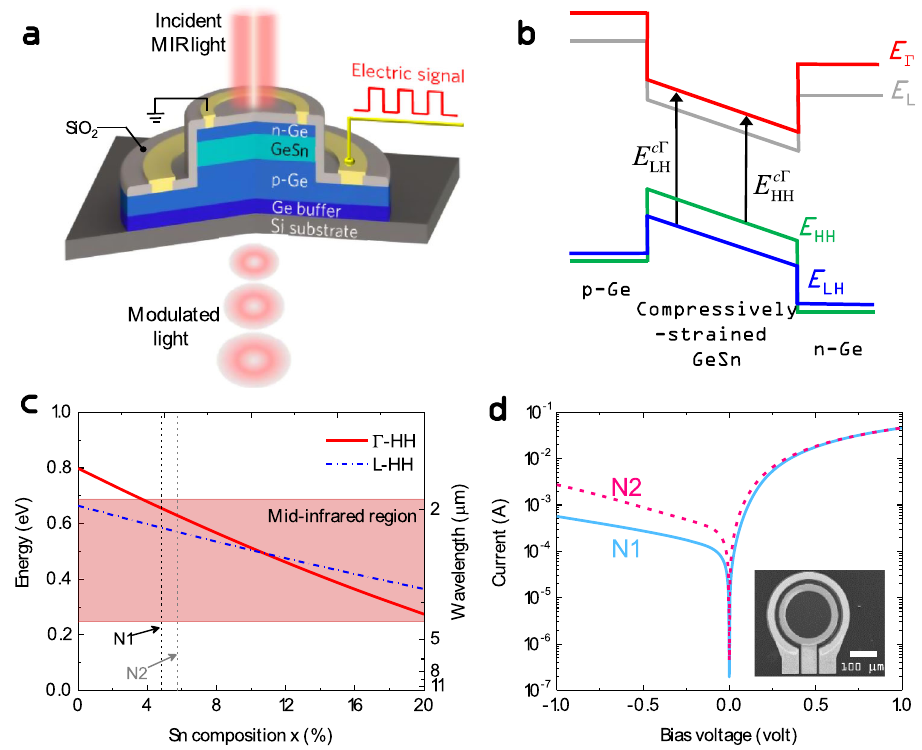
Fig. 2 GeSn p-i-n diodes on silicon for mid-infrared electro-absorption modulation. a Schematic of our designed normal-incident GeSn p-i-n diode on (001) silicon for optical modulation (not to scale). The mid-infrared (MIR) light beam is incident on the top of the device and transmitted through the GeSn active layer. AC bias voltage is applied to the p-i-n diode to modulate the MIR light based on the Franz – Keldysh effect. b Schematic band diagram of Ge/ GeSn/Ge heterojunction with an applied electric fi eld. The compressive strain in the GeSn active layer splits the valence band. c Evolution of the lowest direct-gap transition energy (from the heavy-hole (HH) to Γ -conduction band) and indirect-gap transition energy (from HH to L-conduction band) for pseudomorphic GeSn on Ge at 300 K as a function of Sn composition calculated using deformation potential theory. The epitaxially grown GeSn heterostructure samples N1 and N2 are indicated by the dashed lines. d Current – voltage characteristics of the fabricated GeSn p-i-n diodes with D = 250 μ m using samples N1 (solid blue line) and N2 (dashed red line). The inset shows a top-view scanning electron microscopy (SEM) image of the fabricated